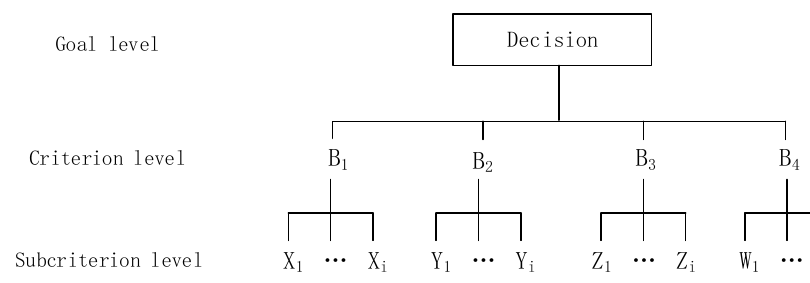
Figure 1. Schematic illustration of the hierarchical structure for the analytic hierarchy process (AHP) method.